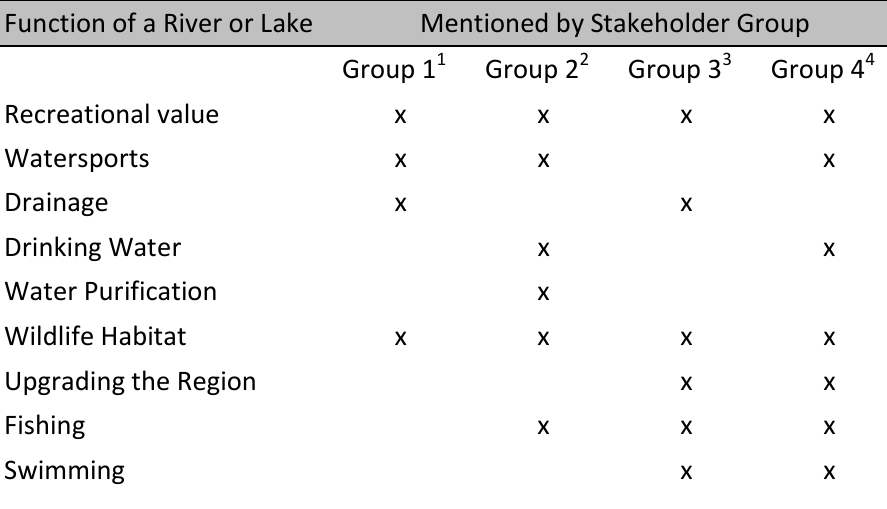
Table 2 Functions of Rivers and Lakes from Stakeholders’